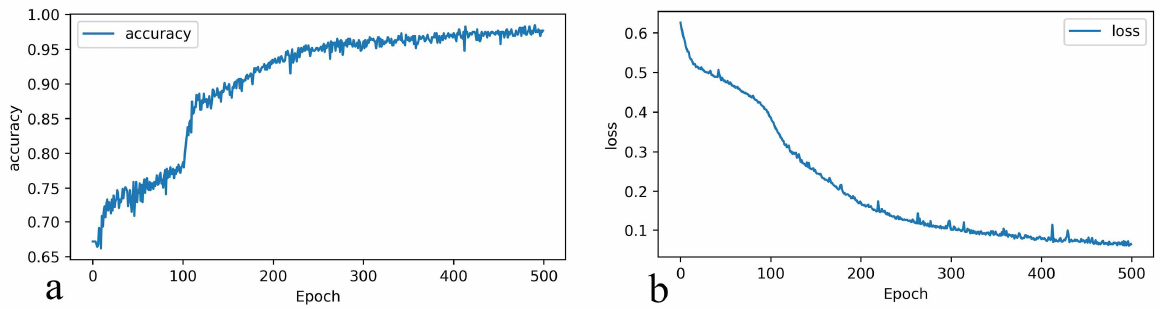
Figure 8. The results of classification of BSA phase separation processed by the neural network. The accuracy and loss functions sparse_categorical_crossentropy converge with the increase of epoch. With the increase of the epoch of training, the accuracy increases ( a ) and the loss function decreases ( b ).